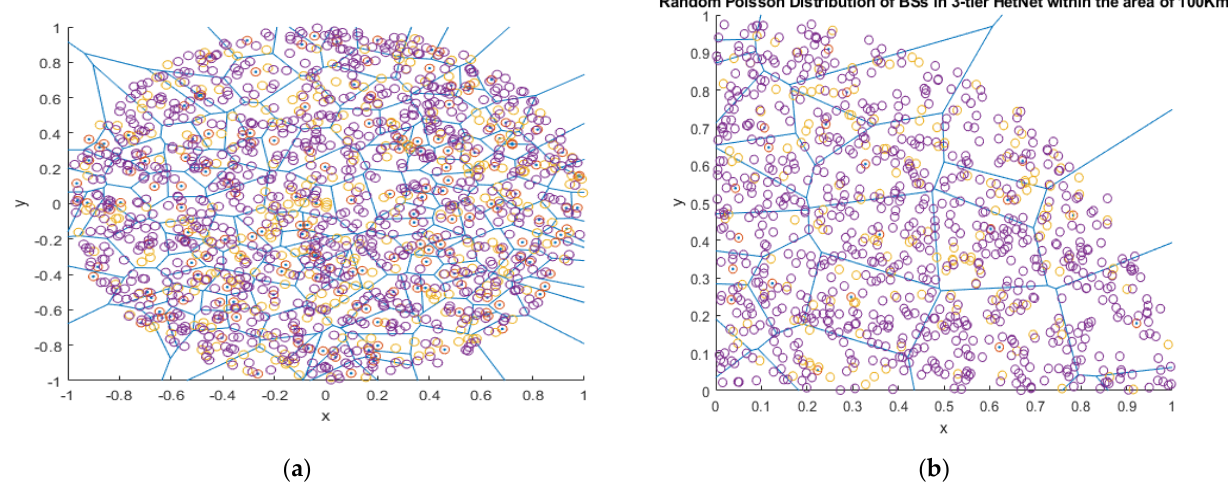
Figure 1. ( a ) A complete view on Voronoi tessellation of a three—tier HetNet with a random Poisson distribution; ( b ) a dissected view of a HetNet with a Poisson random distribution over the area of 100 KM. Red circles with dot represent MBS, yellow circles represent HSBS, and purple circles represent LSBS.